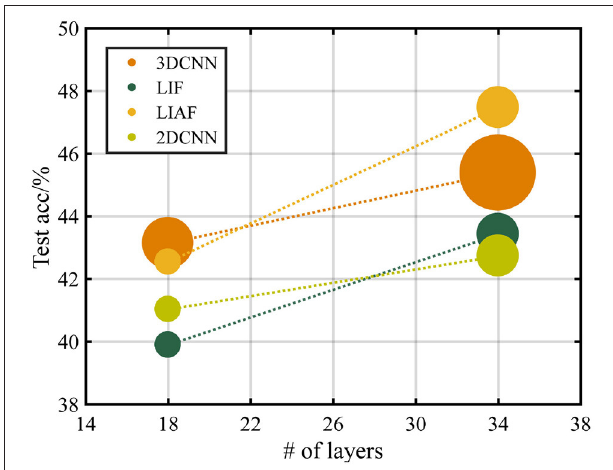
FIGURE 9 | Testing accuracy with the structure of ResNet-18 and ResNet-34. The radius of the data points represents the relative size of the parameters of the networks.